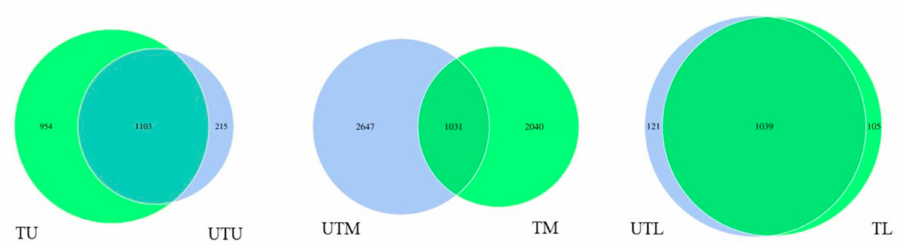
Figure 3. Venn diagrams illustrating the shared and unshared OTUs between each section of the GIT in both flocks. Each circle within the Venn diagram represents a single sample group where U, M and L stands for upper, middle and lower GIT, respectively, and T and UT stand for treated and untreated flocks,